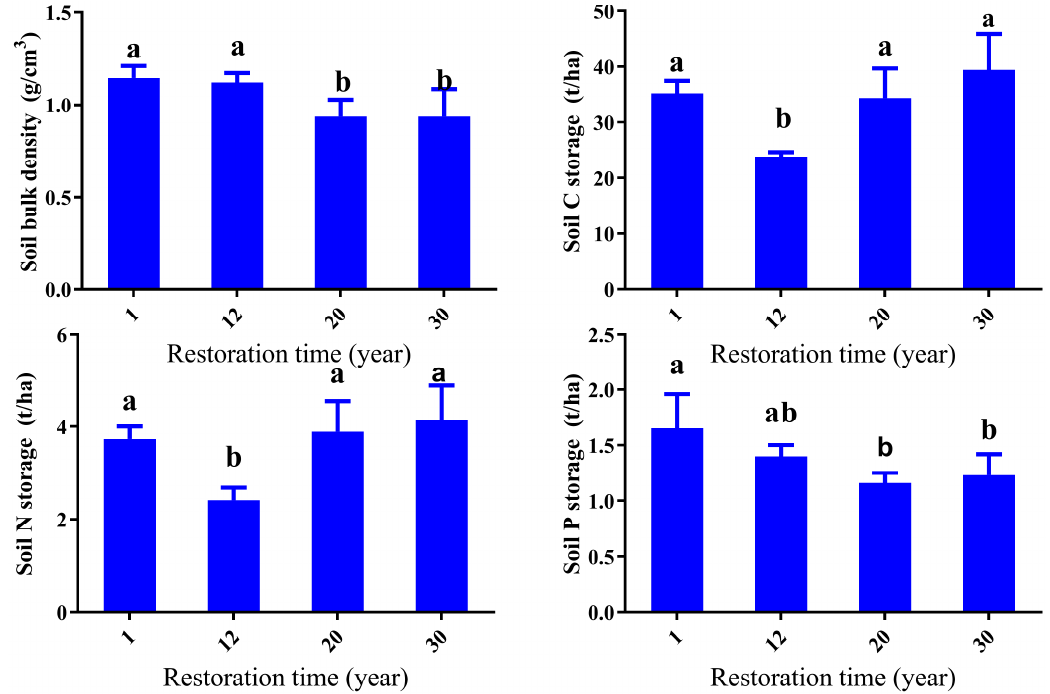
Figure 4. Soil bulk density, carbon, nitrogen, and phosphorus stocks across different succession stages. Different letters indicate significant differences between vegetation sites ( p < 0.05).